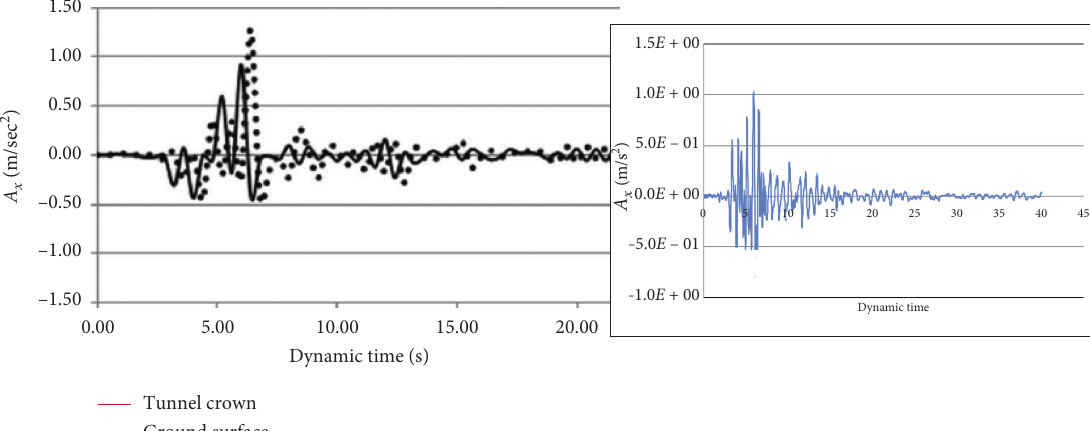
Figure 3: Verification time history analysis with article (Singh et al. 2016) in the Abaqus for horizontal acceleration on the tunnel crown.